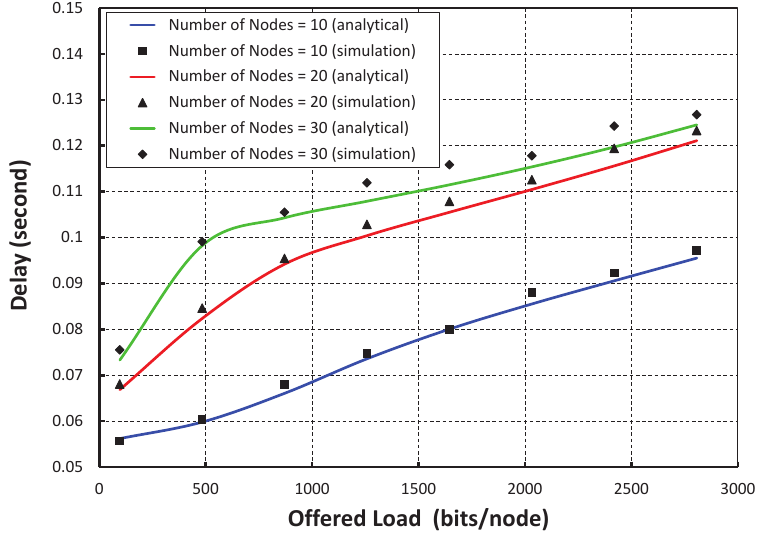
Figure 12. Validation of transmission delay for different offered